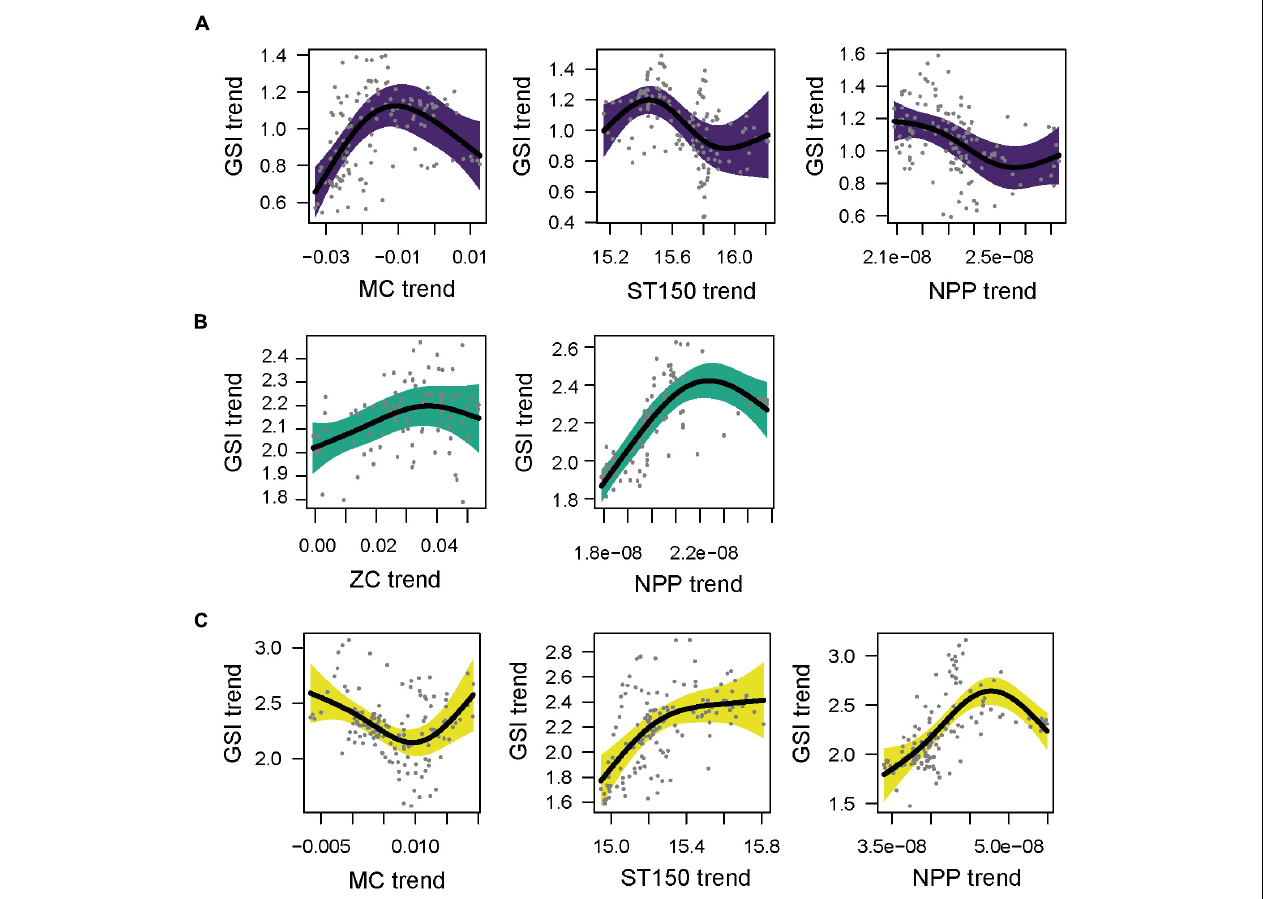
FIGURE 5 | Partial GAM plots for gonadosomatic index (GSI) of sardine females ( Sardina pilchardus ) for each area; (A) North (purple), (B) Central (green), (C) South (yellow). Significant partial effects of meridional current (MC), zonal currents (ZC), average sea temperature of 150 m (ST-150) and net primary production (NPP) are represented. The shaded areas indicate the 95% confidence